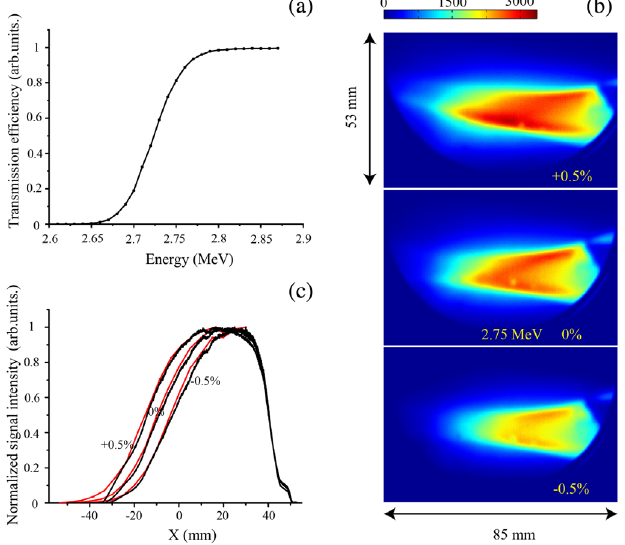
FIG. 5. Energy resolution testing using the foil cutoff method. (a) Transmission efficiencies of protons with different energies through a 70 - μ m -thick aluminum foil. The quadrupole doublet magnet was turned off and the image point of the sector magnet was adjusted onto the MCP. (b) Proton beam profiles on the MCP with central energies differing from 2.75 MeV by 0.5%, 0% and − 0 . 5 % respectively from top to bottom. (c) Normalized signal intensity along the x direction for the three energy conditions. From left to right, the differences of central energies are 0.5%, 0% and − 0 . 5 % from 2.75 MeV, respectively. The black curves are the experimental data and the red curves are theoretical